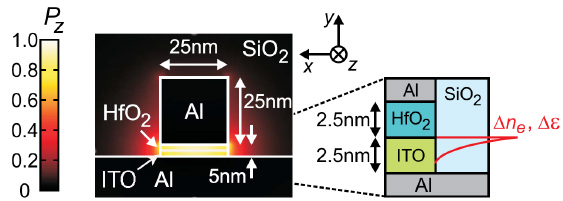
Figure 10: Design of nanowire-based modulator with the size 25 × 25 nm 2 : SPP mode in a nanowire-MIM waveguide and a zoom of the active region with the change of electron density ∆ n right (2012), American Physical Society, from Ref. [138], with per- mission of the authors. MIM: Metal-insulator-metal; SPP: Surface plasmon polaritons